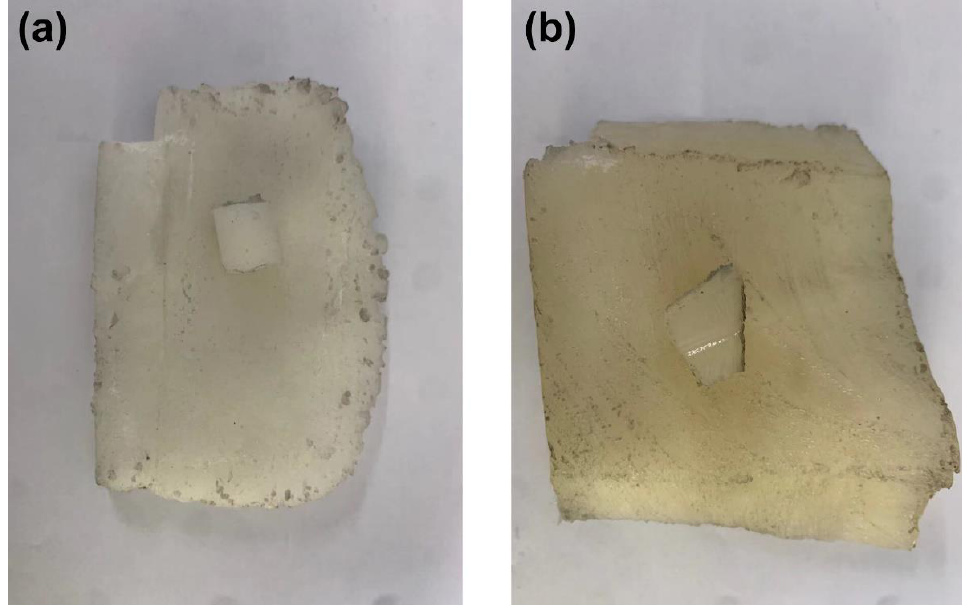
Figure 1. The raw rubber material ( a ) and the sample ( b ).